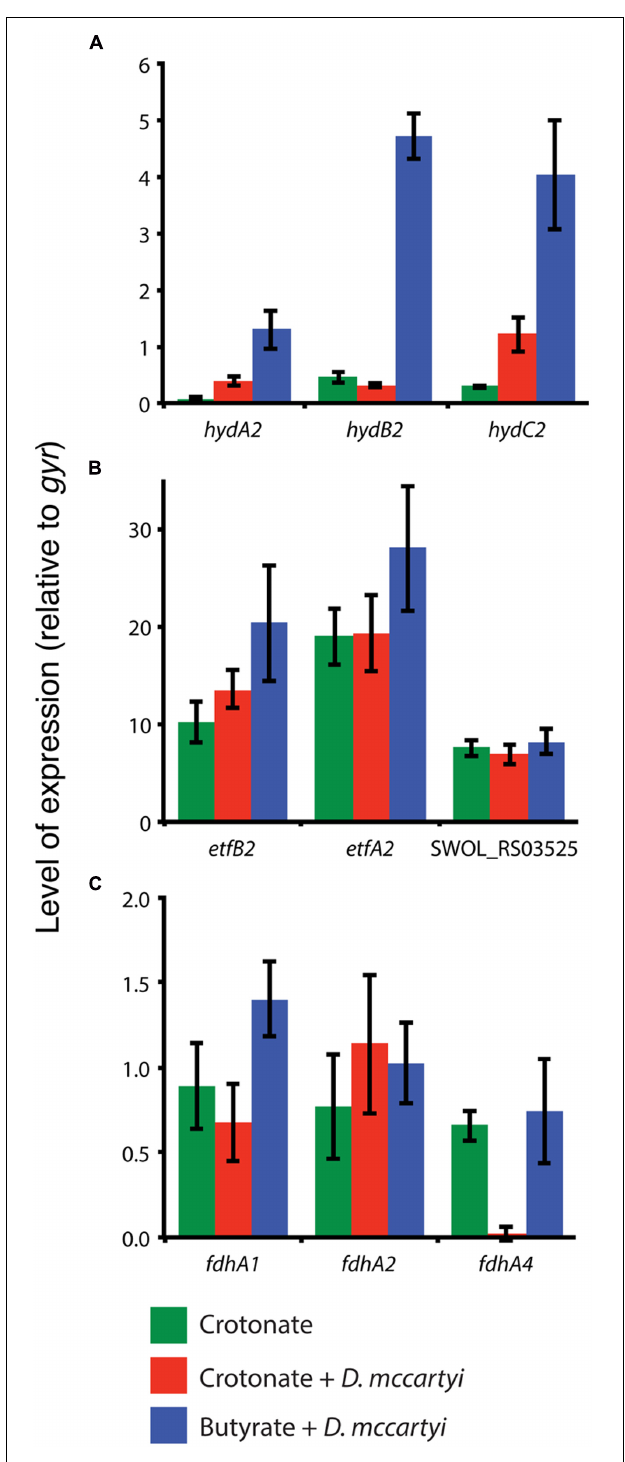
FIGURE 2 | Expression of hydABC2 (SWOL_RS09950, SWOL_RS09955 and SWOL_RS09960) (A) , etfAB2 (SWOL_RS03515 and SWOL_RS00520) and SWOL_RS03525 (FeS oxidoreductase) (B) and formate dehydrogenase (C) genes in S. wolfei grown in axenic culture on crotonate (green), in co-culture with D. mccartyi on crotonate (red) or in co-culture with butyrate